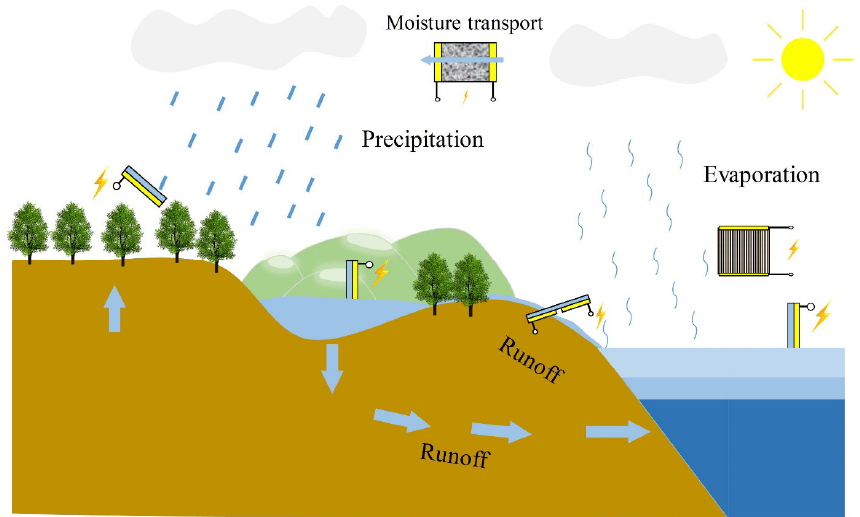
Figure 1 Harvesting energy from the water circle in